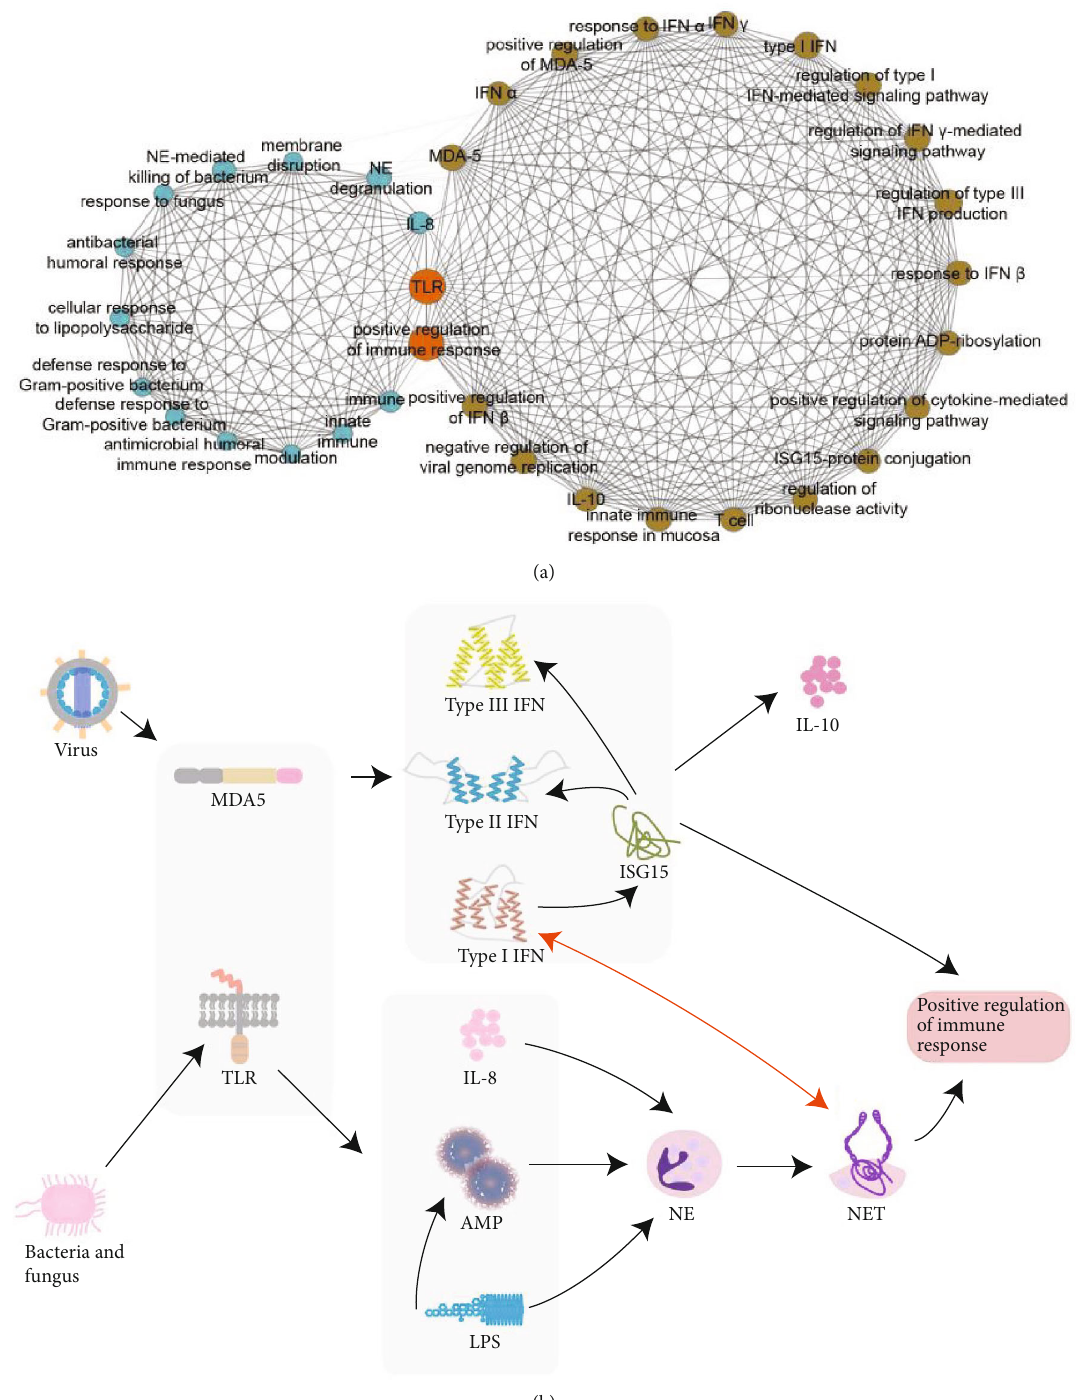
Figure 4: Mode mechanism of subtype. (a) Coexpression network of BPs in the mixed type. Each point in the network represents a kind of BP, the edges represent the correlation between functions, and the size of the edge represents the strength of the correlation. Points in the two communities are marked with di ff erent colors, and important bridge nodes are marked with orange. (b) Mechanism of immune dysfunction in mixed type. Viral infections and bacterial and fungal infections show di ff erent pathogenic pathways. Viral infections cause immune disorders by activating the overexpression of IFN; bacterial and fungal infections induce autoimmune reactions by inducing NE to produce